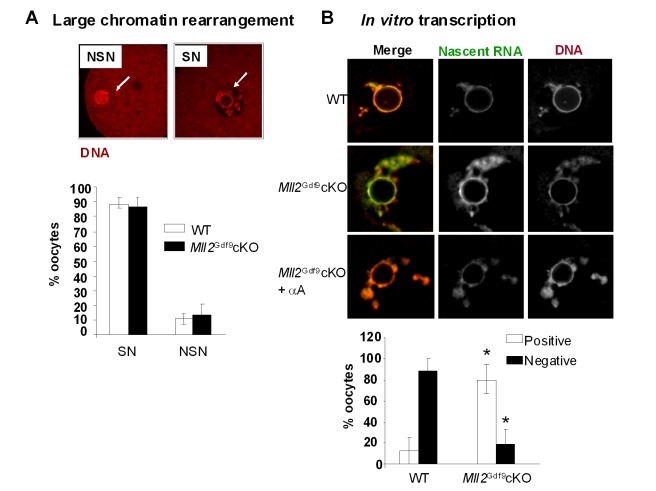

Mll2Gdf9 cKO oocytes fail to establish transcriptional repression.(A) Confocal laser microscopy analysis of peri-ovulatory oocytes stained with propidium iodide to visualize DNA (upper panel); oocytes were scored as displaying a surrounded nucleolus (SN) or a non-surrounded nucleolus (NSN) configuration (lower panel). Arrows show the nucleolus. No significant differences were observed between controls and Mll2Gdf9 cKO oocytes (ANOVA test, * p = 0.08). Means ± S.E. are shown; a total of 170 oocytes from five individual females were analyzed in three independent experiments. Magnification: 800×. (B) Run-on and confocal microscopy analyses of Br-UTP labeled nascent RNA in peri-ovulatory oocytes. Upper panel: Representative single plane confocal micrographs are shown as merge and split channels (Br-UTP, green staining; and DNA: propidium iodide, red staining). Lower panel: oocytes were scored as positive or negative for Br-UTP staining; note that Mll2Gdf9 cKO oocytes were transcriptionally active (ANOVA test, * p<0.05). Transcription was RNA Pol II dependent as it was abrogated by α-amanitin (αA) (magnification: 800×). Means ± S.E. are shown; a total of 90 oocytes from four individual females were evaluated in three independent experiments.